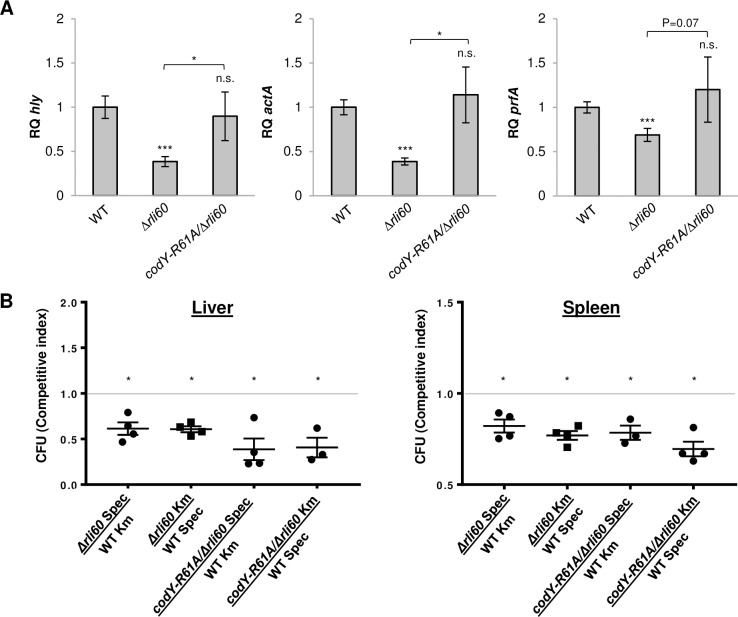
Restriction of BCAA biosynthesis promotes Lm virulence.(A) qRT-PCR analysis of hly, actA and prfA transcription levels in WT Lm and indicated mutants grown in LBMM. mRNA levels are represented as relative quantity (RQ) and normalized to rpoD. The data represent 4 biological replicates (N = 4). Error bars indicate standard deviation. Asterisks represent P-values (* = P<0.05, ** = P<0.01, *** = P<0.001, n.s. = non-significant), calculated using Student’s t-test. (B)
Δrli60 and codY-R61A/Δrli60 bacteria are attenuated for virulence compared to WT Lm bacteria during in-vivo competitive infection of mice. Bacterial loads in the spleens and livers of C57BL/6 mice after 2 days of infection with a 1:1 ratio of WT Lm and mutant bacteria (either Δrli60 or codY-R61A/Δrli60). pPL2 containing a Kanamycin (Km) or Spectinomycin (Spec) resistance cassette were used to identify each bacterial strain. The experiment was done reciprocally, switching the antibiotic cassete between the two strains. Colony forming units (CFU) of mutant bacteria in each organ are presented as relative to the CFU of WT bacteria and are significantly different from CFU (WT/Mutant) = 1, calculated using Student’s t-test (* = p<0.05). Mutant Km/WT Spec CFU is not significantly different from the reciprocal Mutant Spec/WT Km CFU.